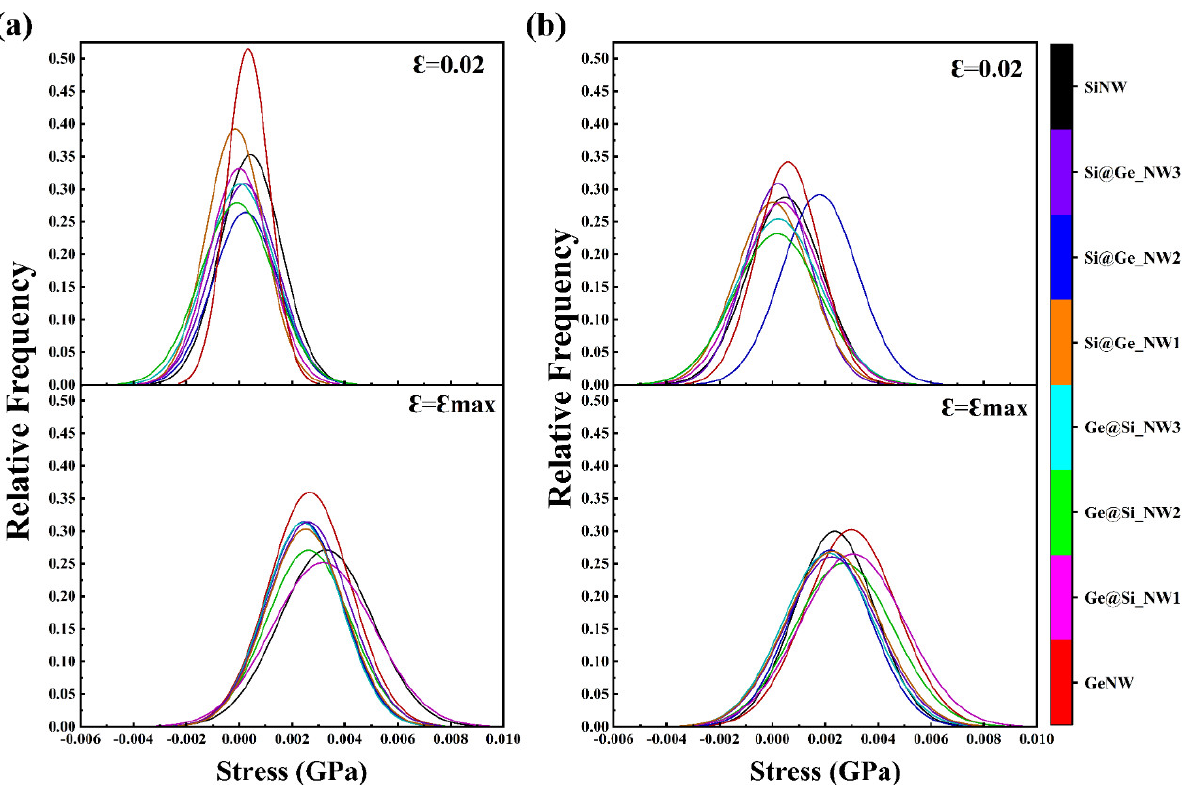
Figure 7. Pressure distributions on the atoms for the Ge@Si and Si@Ge nanowires with different core–shell ratios at different temperatures during stretching processes: ( a ) 300 K; ( b ) 800 K.